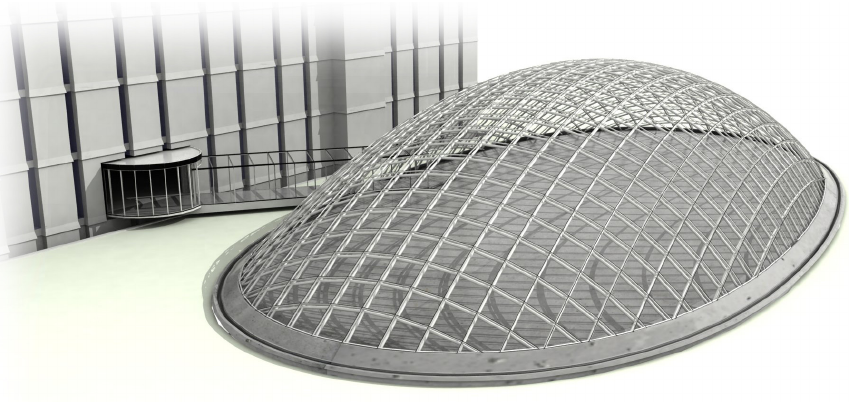
Figure 1: Rendering of the Joe and Rika Mansueto Library (© Glasbau Seele,